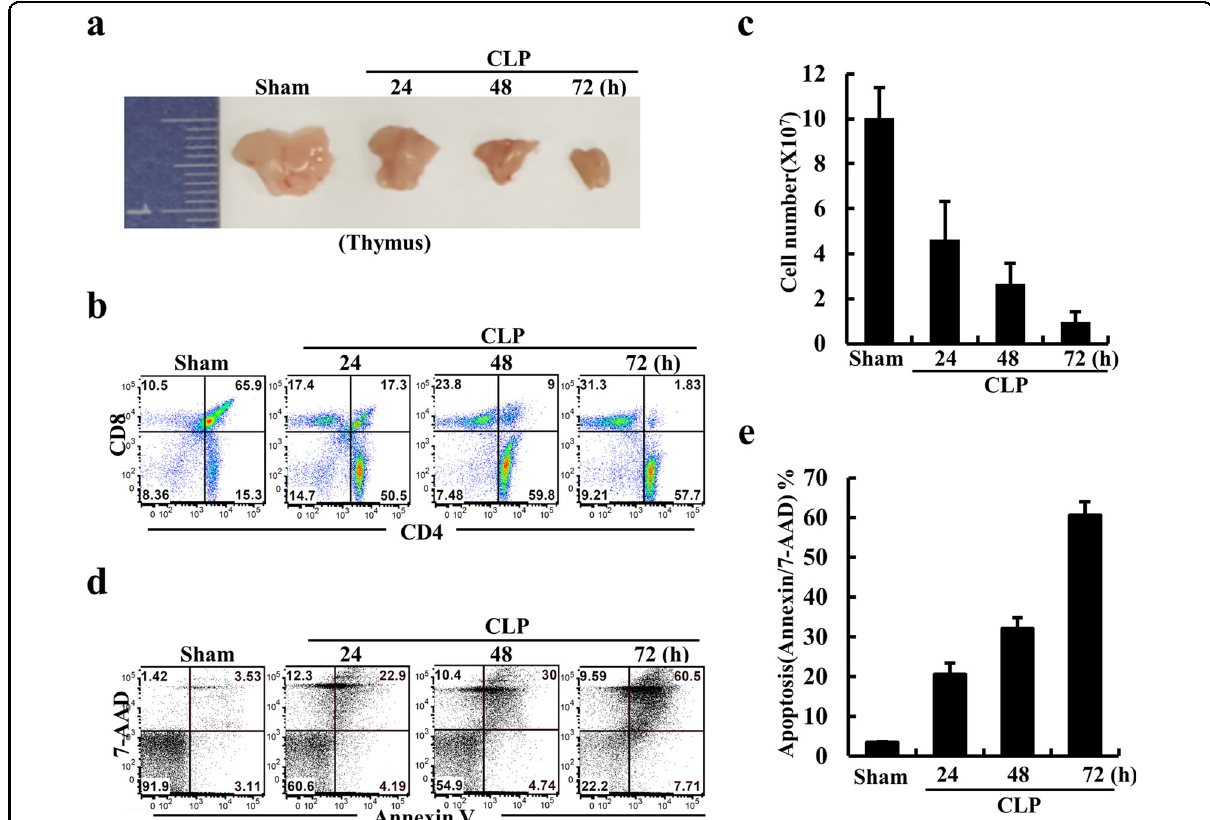
Fig. 1 Analysis of thymus from CLP mice. a Thymus were isolated from sham- and CLP-induced mice at the indicated time points. b Total thymocytes were isolated from thymus prepared in ( a ). Cells were stained with CD4 and CD8 antibodies, and analyzed by fl ow cytometry. c Total thymocytes prepared in ( a ) were counted. d To detect apoptosis, total thymocytes prepared in ( a ) were stained with Annexin V and 7AAD, and analyzed by fl ow cytometry. e The data indicates the percentage of apoptotic cells. The data represent the mean ± S.E.M. of three separate experiments. Sham mice indicate sham-operated mice and CLP mice indicate CLP-induced